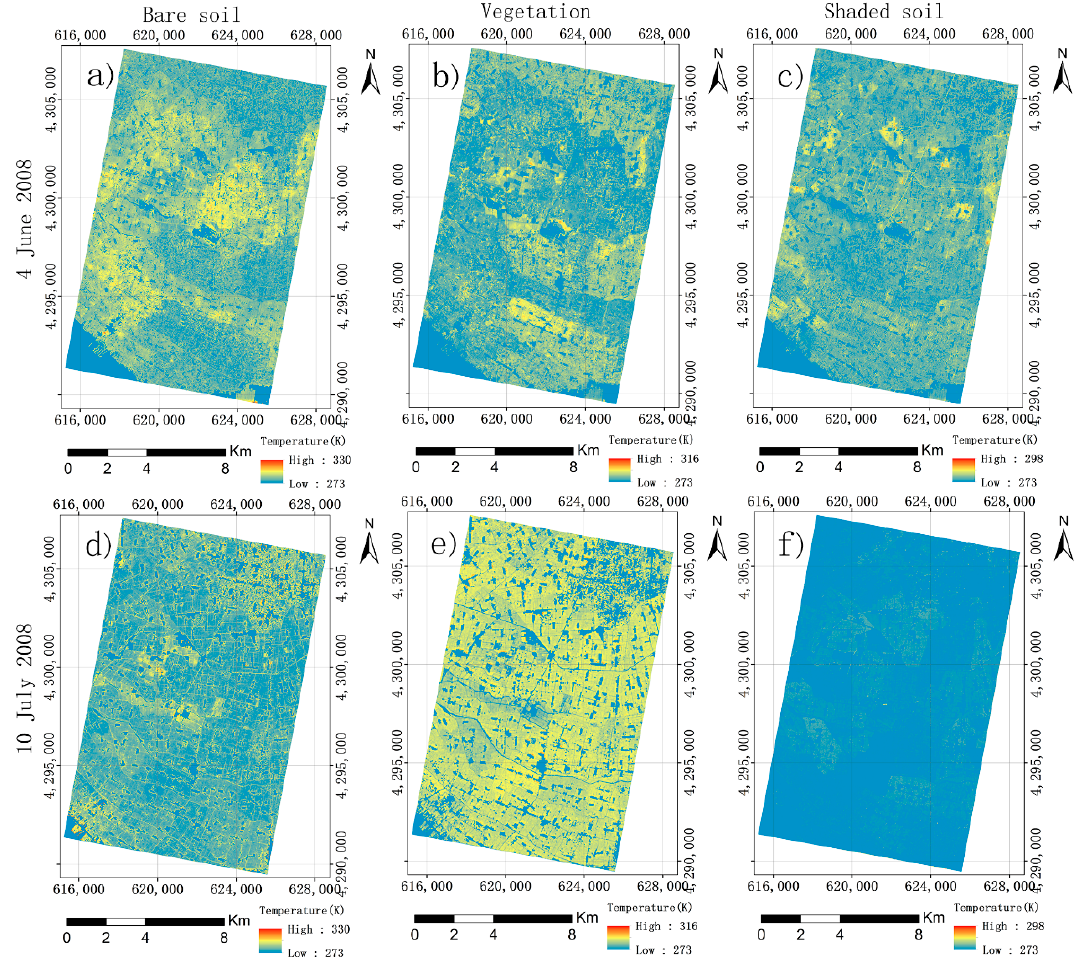
Figure 8. The spatial distributions of temperatures obtained based on three component fraction maps derived from ASTER data using a spectral unmixing analysis for the study area: ( a ) and ( d ) bare soil; ( b ) and ( e ) vegetation; and, ( c ) and ( f ) shaded area for the June 4 th and July 10 th images of 2008, respectively.